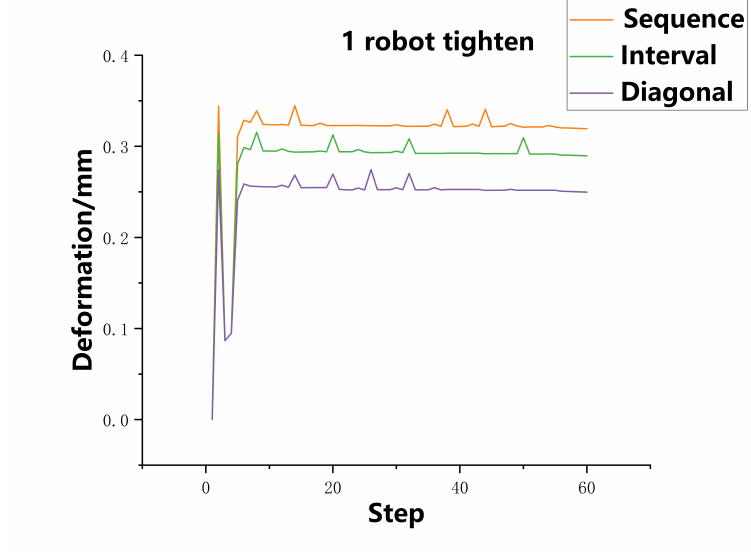
Figure 11. Deformation of one robot tightening aerospace